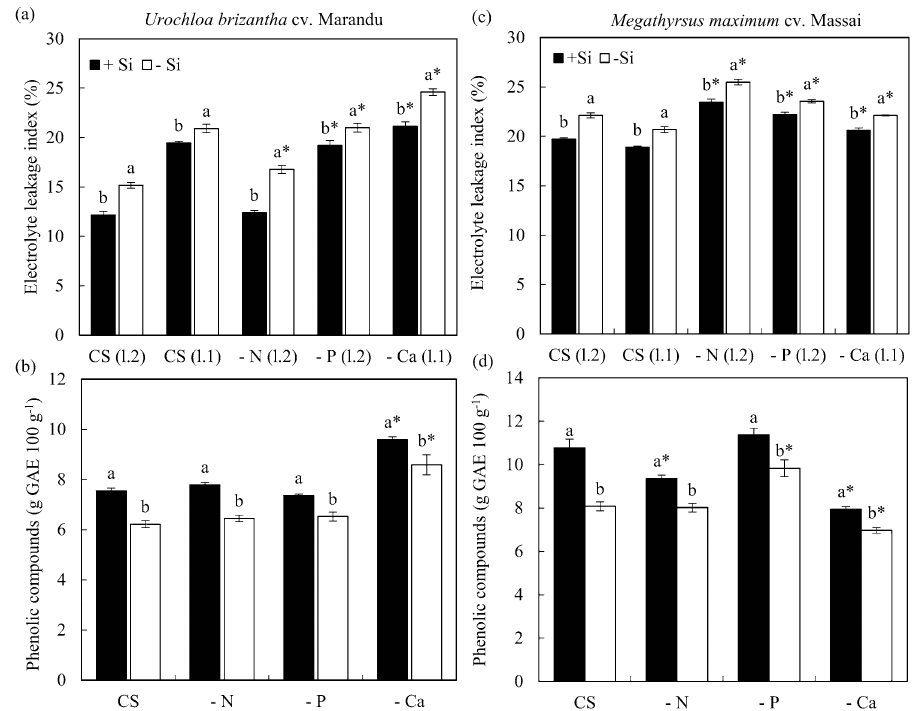
Figure 2. Electrolyte leakage index ( a , c ) and phenolic compounds ( b , d ) of Urochloa brizantha cv. Marandu and Megathyrsus maximum cv. Massai under grown in complete solution (CS) and deficiency of nitrogen (−N), phosphorus (−P) and calcium (−Ca), combined with Si (+Si) and without Si (−Si). Different letters indicate a significant difference between treatments in the +Si and −Si condition. *Indicates a significant difference between treatments with nutritional deficiencies in relation to treatments with CS. For the electrolyte leakage index the treatments of CS (l.2) are compared with the treatments −N (l.2), −P (l.2), refer to values obtained by the evaluation of the second fully expanded sheet. The treatments of CS (l.1) are compared with the values of − Ca (l.1) and refer to the first leaf. The comparison of means was performed using the Tukey test ( p <